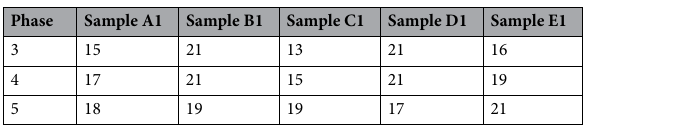
Table 3. Dimensions of phase spaces in different stages of a